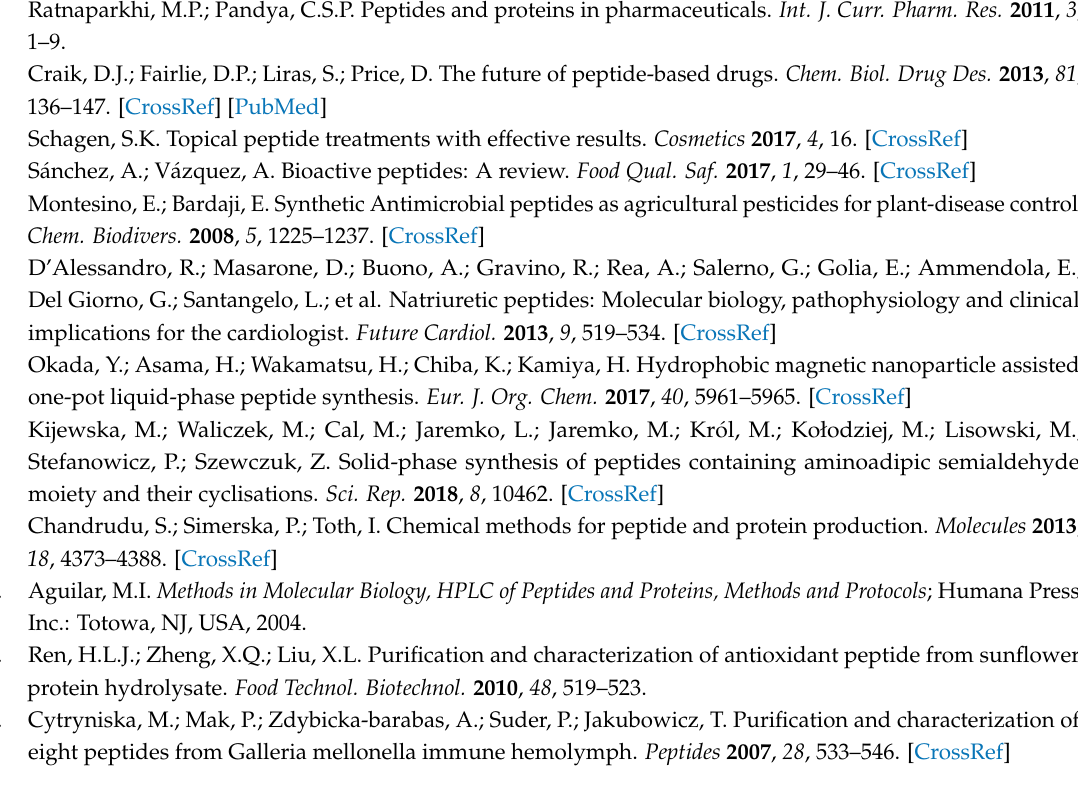
Supplementary Materials: The following are available online, Figure S1: Purification of a peptide containing seventeen amino